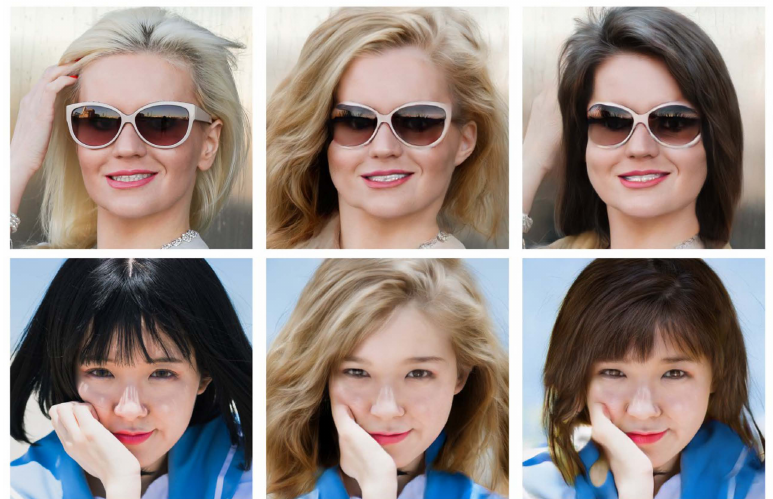
Figure 10. Face image with face